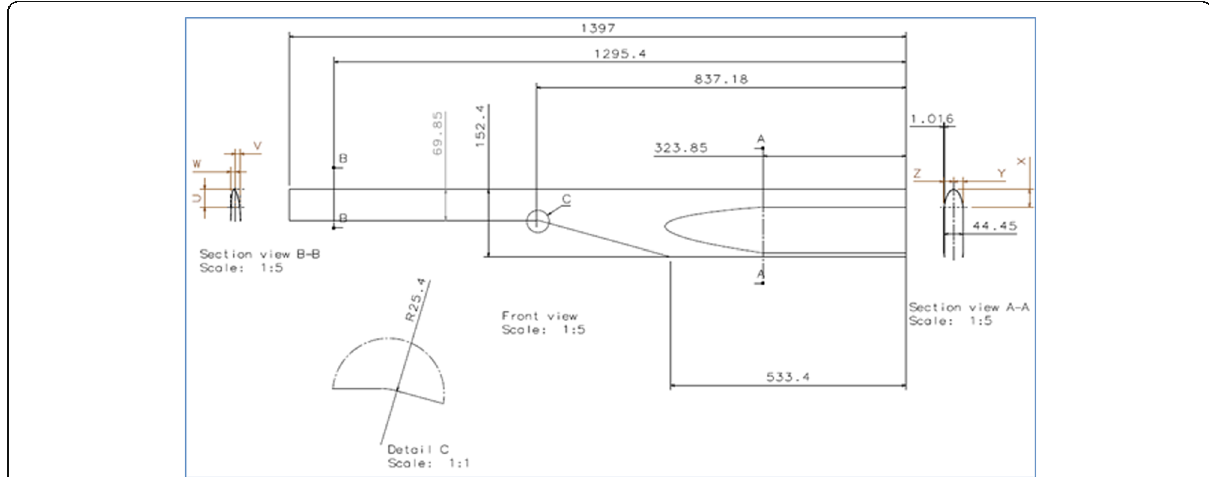
Fig. 2 Sketch of the helicopter tail rotor is designed to cover the rubbing